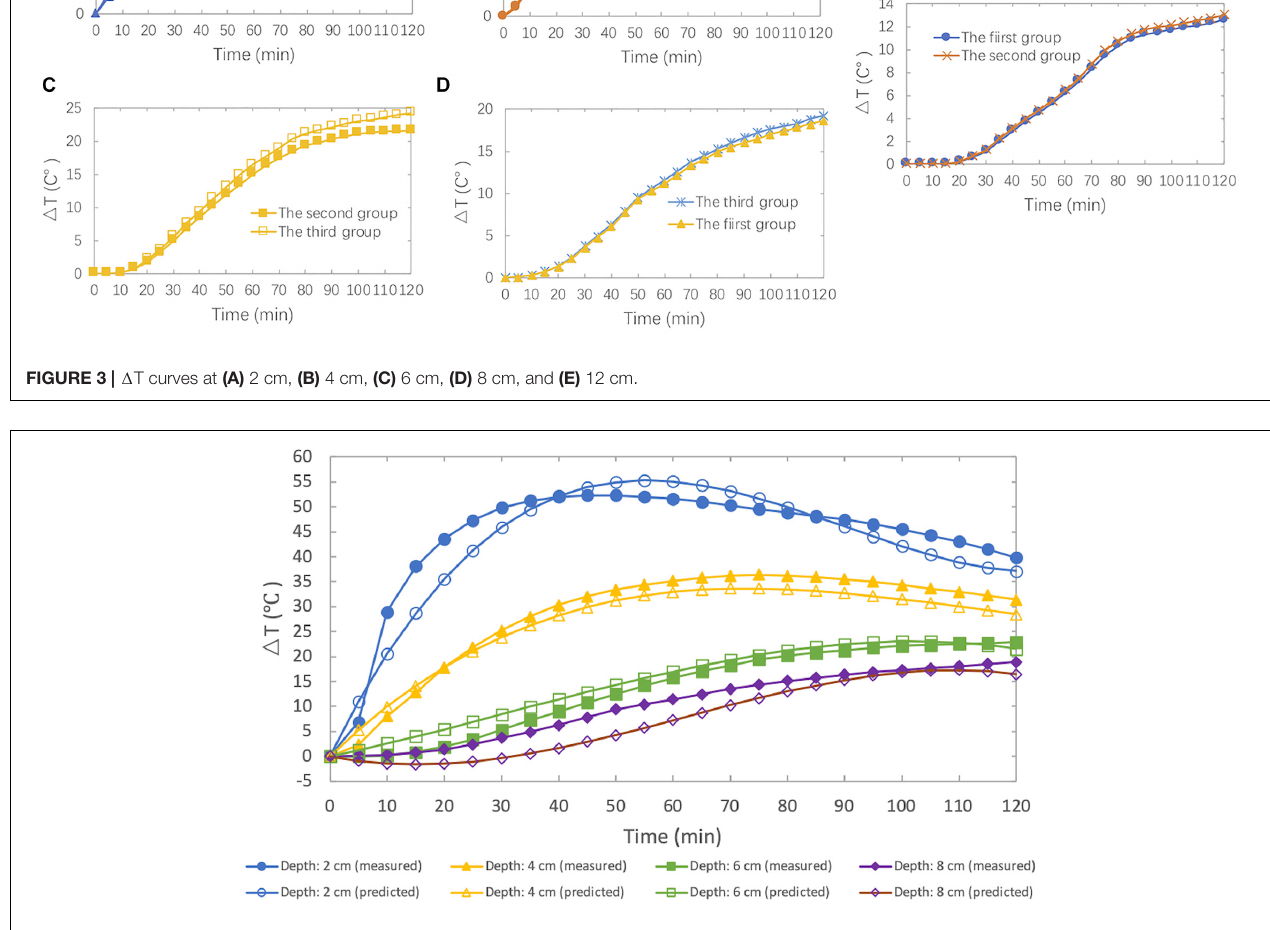
FIGURE 4 | Comparison between measured data and prediction